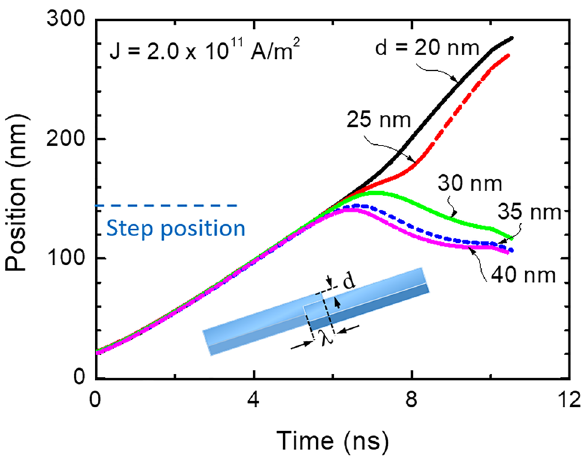
Figure 5. The position of the skyrmion versus time for λ = 0 and different values of d